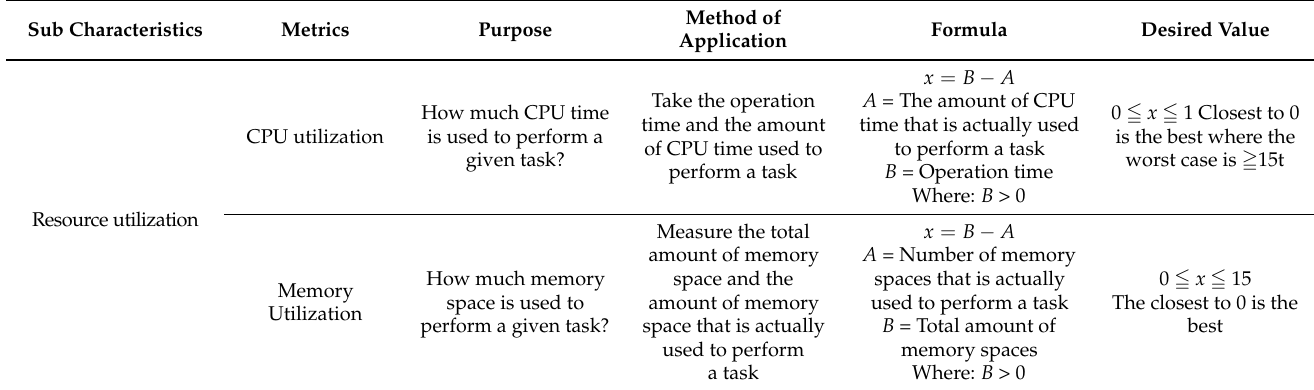
Table 2. Evaluation table for ISO/IEC 25030 resources